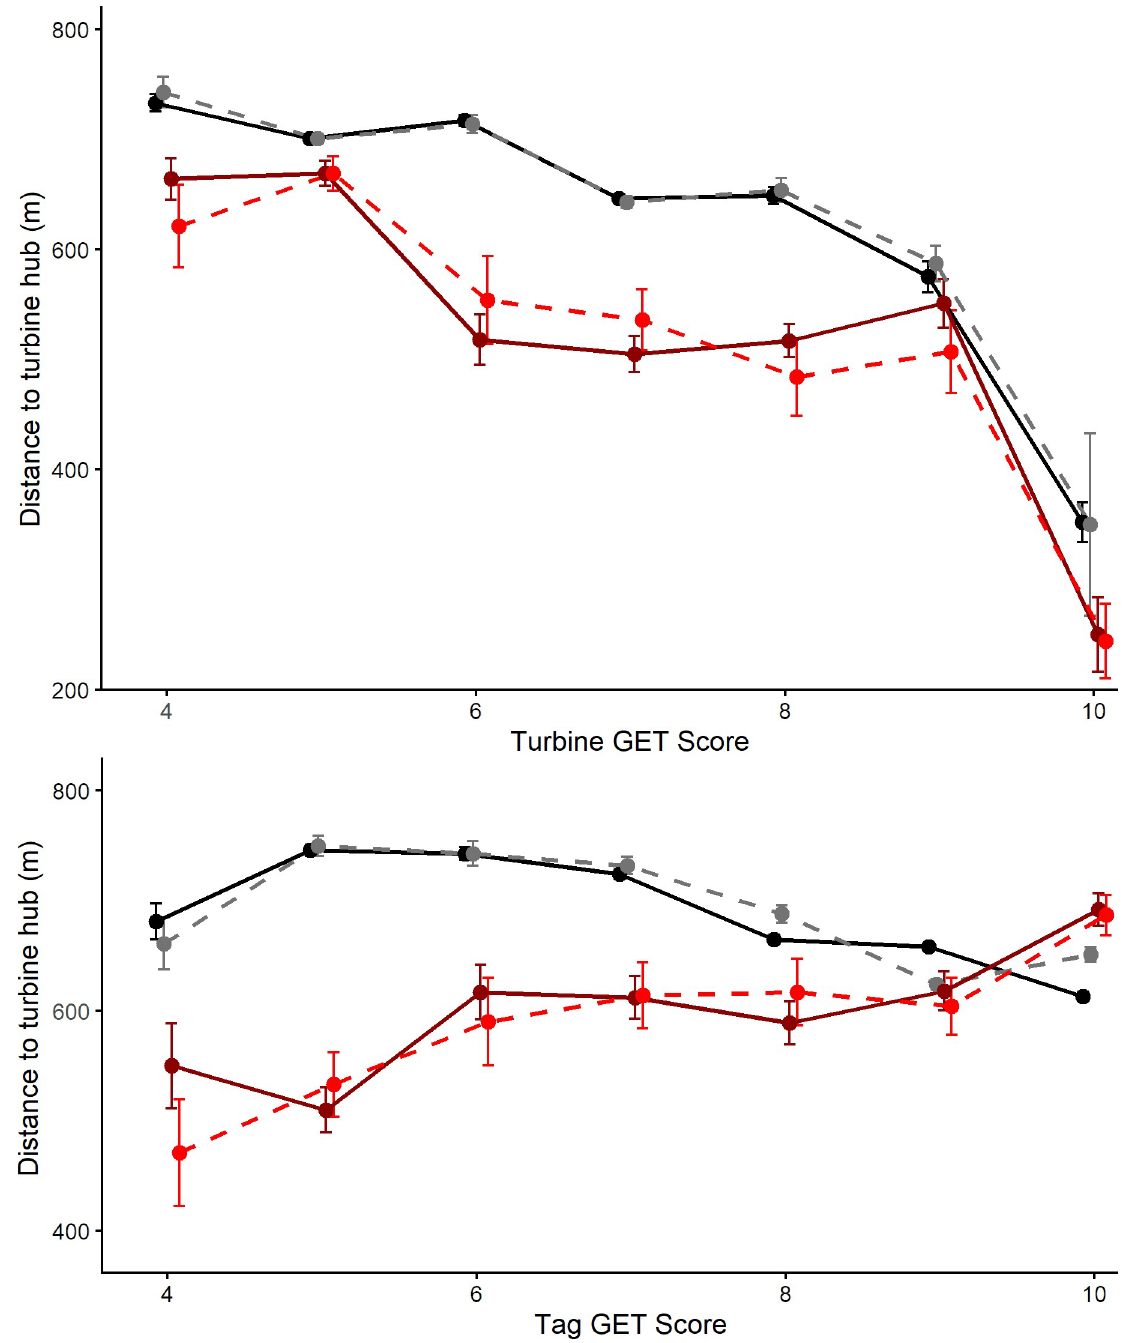
Fig 2. Mean distances to turbine hubs, with 95% confidence limits, in relation to the operational state (before and after). Solid lines are fitted distances from the best model, dashed lines are observed distances. Black and gray lines are post-operation distances while red and dark red lines are before-operation distances. The upper plot is the GET score at the turbine location and the lower plot is the GET score at the birds’